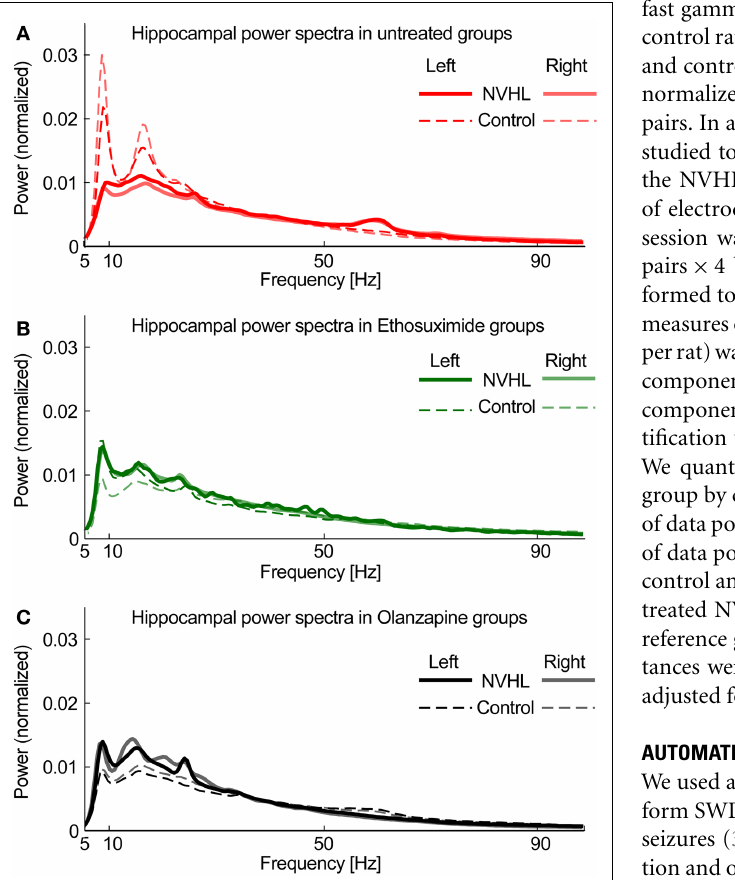
filter using a zero phase-shift filtering algorithm followed by